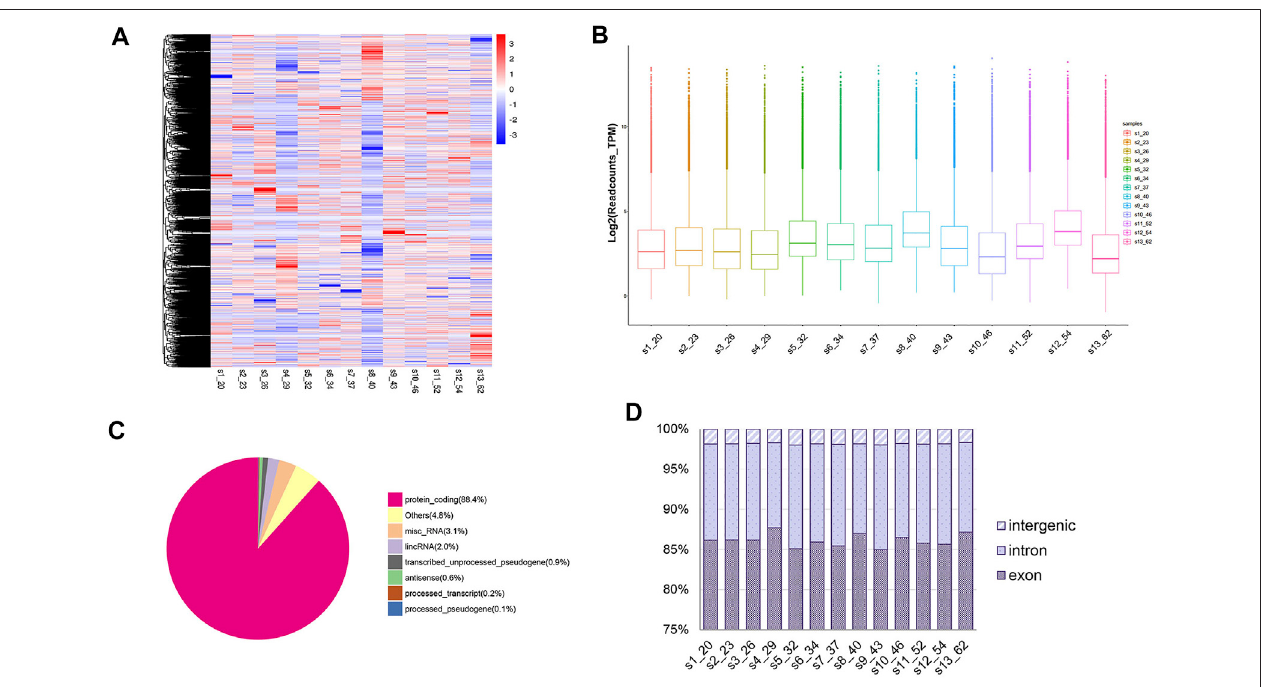
FIGURE 1 | Landscape of circRNA pro fi les in sequencing samples. (A) Heatmap of circRNA expressions across all 13 samples; (B) Box plots of circRNA TPM readcounts between different ages. (C) Classi fi cation of mapped reads taking sample 1 (20 years old) for example. (D) Genomic features of circRNAs in each sample.